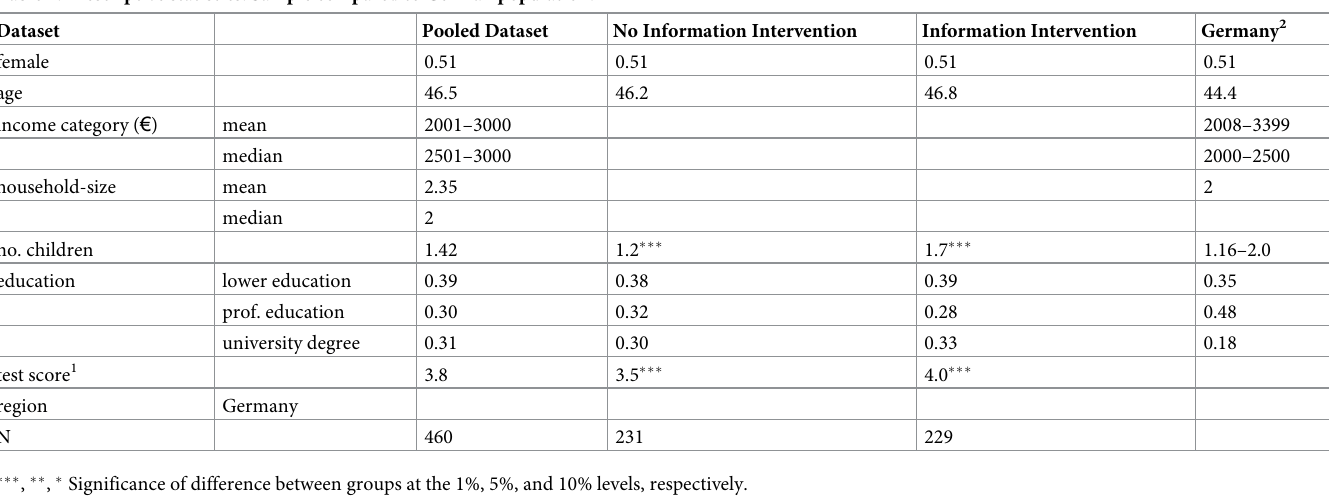
Table 2. Descriptive statistics: Sample compared to German population.